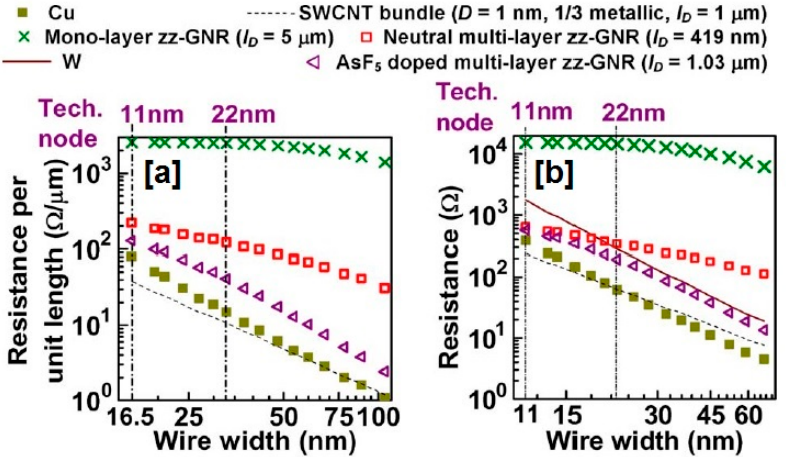
Figure 15. Resistance comparison of SWCNT bundles, mono-layer zigzag (zz)-GNR, ML-zz-GNR, tungsten (W) and AsF 5 doped ML-zz-GNR as ( a ) global and ( b ) local interconnects. W is not considered for global wires because of its high resistivity [8]. Reproduced with permission from [8]. IEEE, 2009.